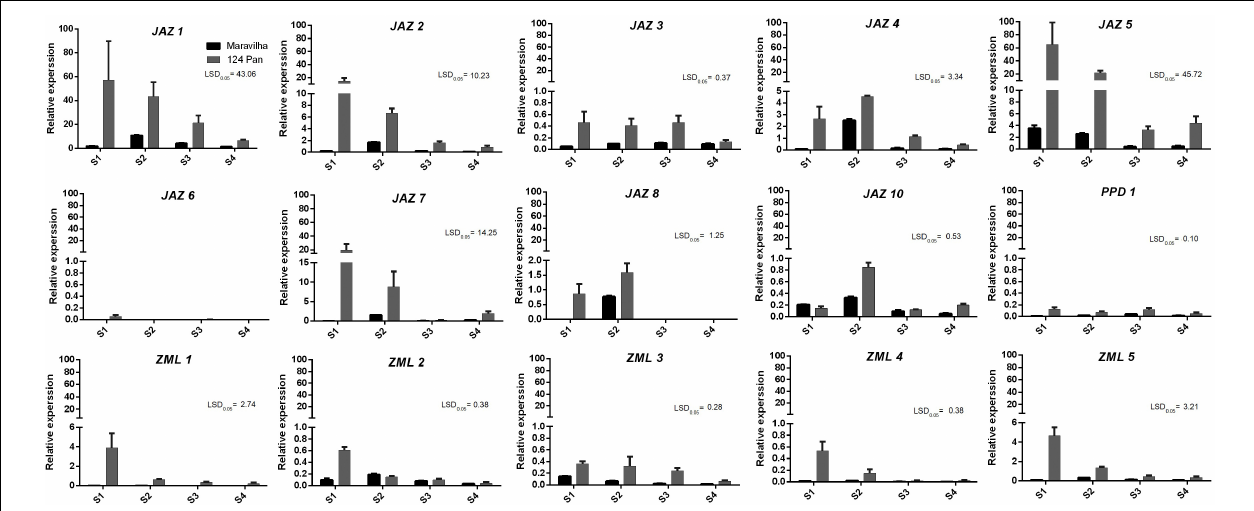
FIGURE 5 | Expression profiles of the peach JAZ , PPD or ZML genes in fruits of “Maravilha” and “124 Pan” throughout fruit development. The x -axis “S1,” “S2,” “S3,” and “S4” represent different fruit developmental stages. S1, the first exponential growth stage; S2, the pit hardening stage; S3, the second exponential growth; S4, fruit ripening stage. The sampling times for stage S1 of “Maravilha” and “124 Pan” (15 days after full blooming) were the same with that of “Zao Huang Pan Tao” (Guo et al., 2018), but much earlier than that of “Hujingmilu” (34 days after full blooming, Cao et al., 2019). The y -axis represents the relative expression of TIFY members to the internal reference gene PpTEF2 . The error bars represent ± SE of three biological replicates. Any difference between two group means greater than LSD 0 . 05 is considered significantly different.